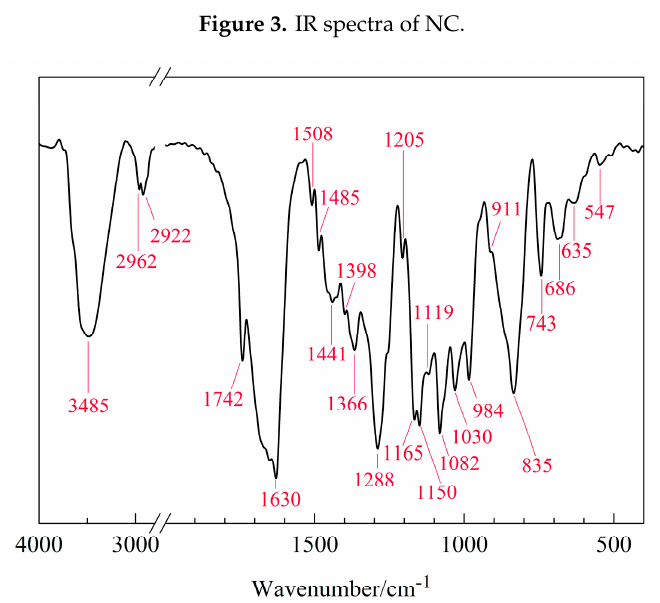
Figure 4. IR spectra of NC-g-AISO.